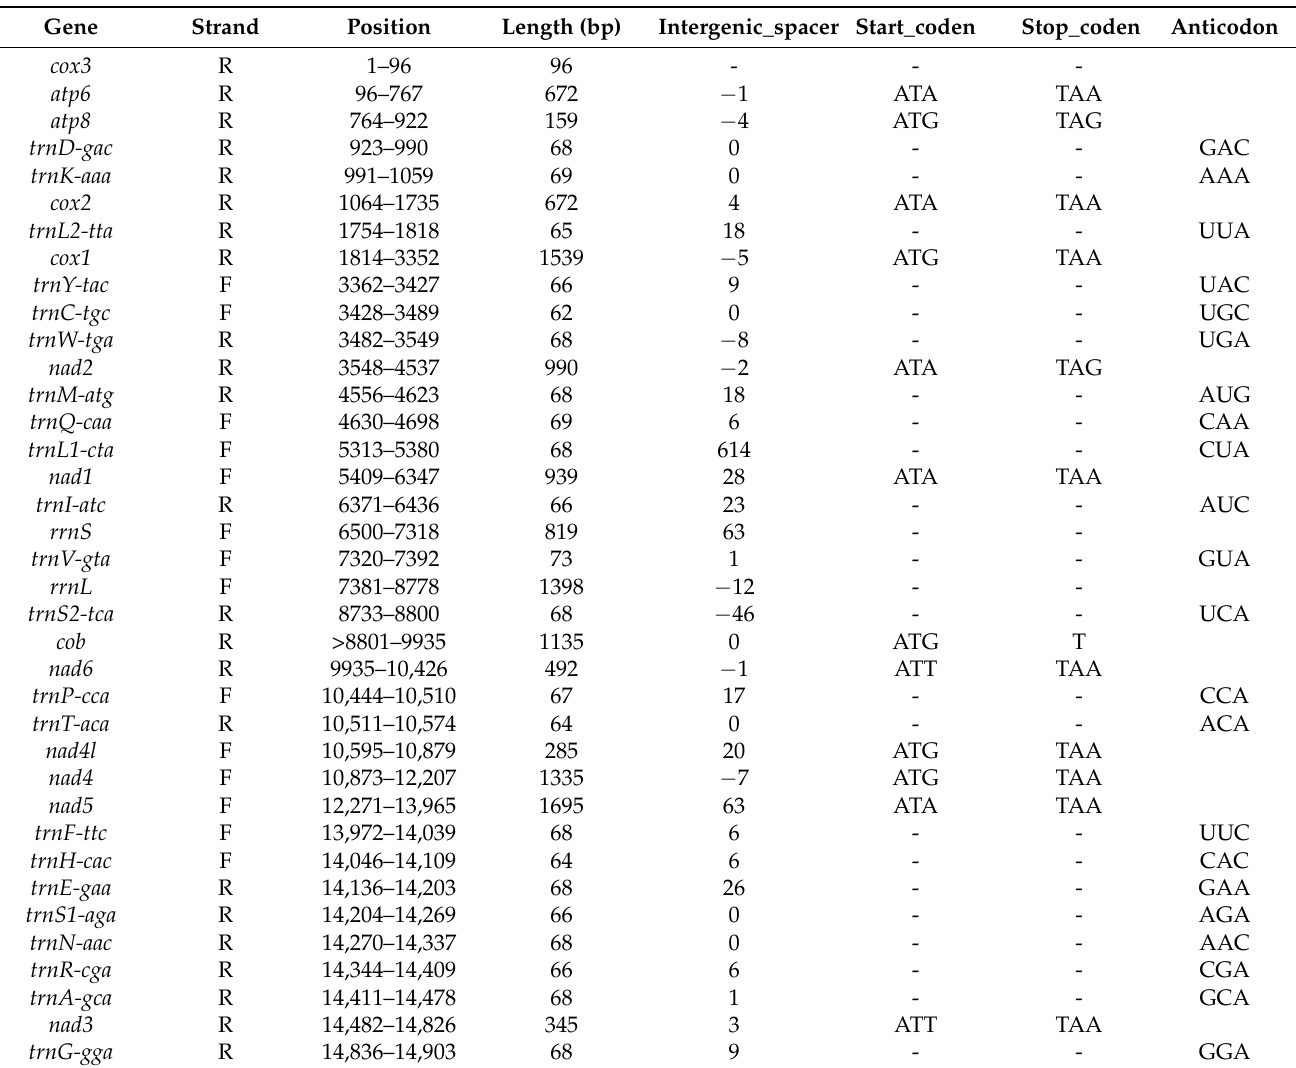
Table 2. Mitogenome organization of E. crenata